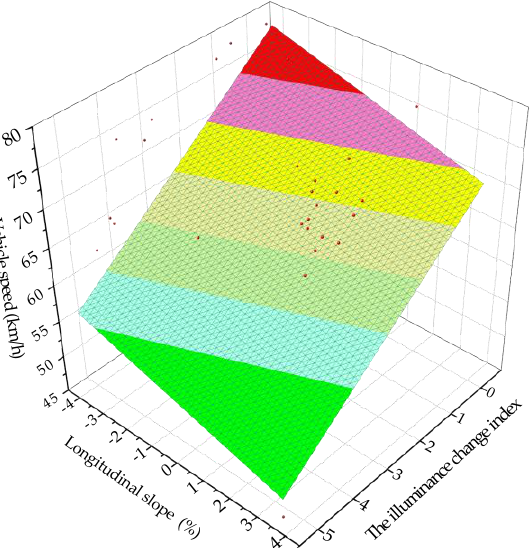
(11) where y 3 is the vehicle speed (km/h), x is the longitudinal slope (%) and q is the illumi- nance change index. The fitting determination coefficient R 2 is 0.93, indicating that the